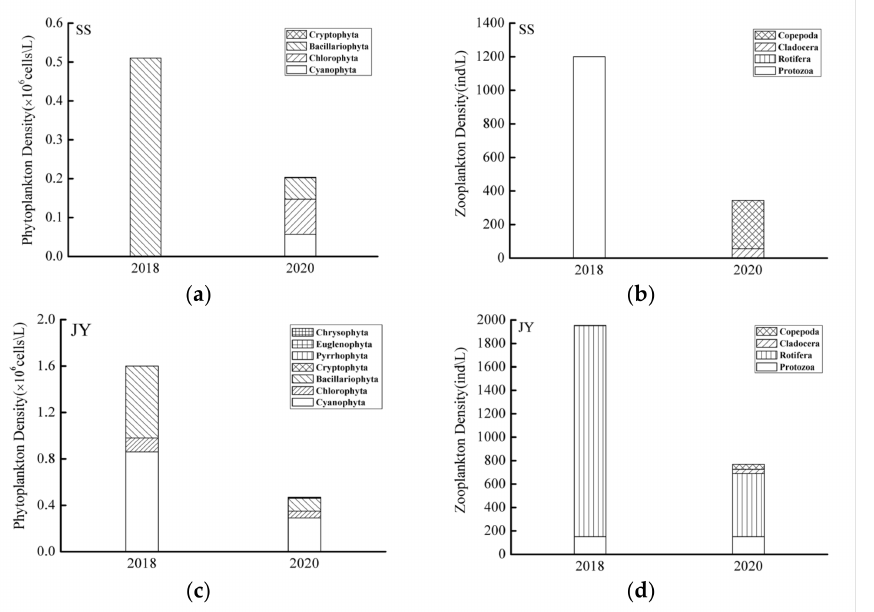
Figure 3. Variation characteristics of phytoplankton and zooplankton density in Shishou ( a , b ) and Jiayu ( c , d ) river reaches, respectively, in different years.